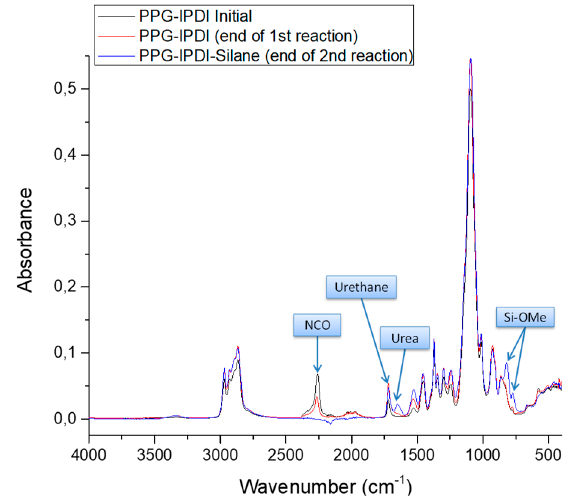
Table 4. The assignments of functional groups of SPUR 8.